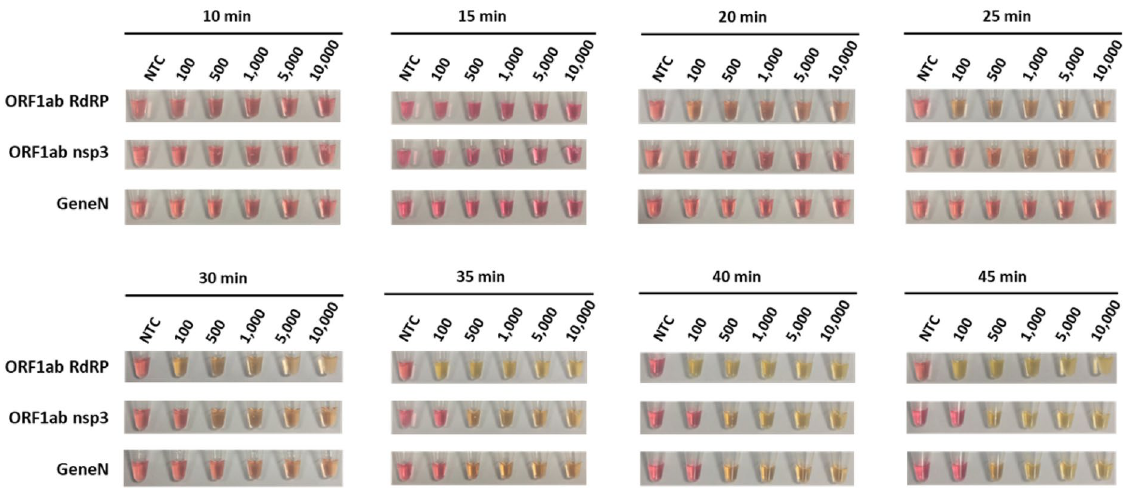
Figure 3. Colorimetric detection of SARS-CoV-2 RNA using RT-LAMP. RT-LAMP reactions are assessed at different time points using a dilution series of positive RNA control ranging from 100 copies to 10,000 copies. NTC (no template control) is used as a negative control. n = 3 biological repeats. Primer